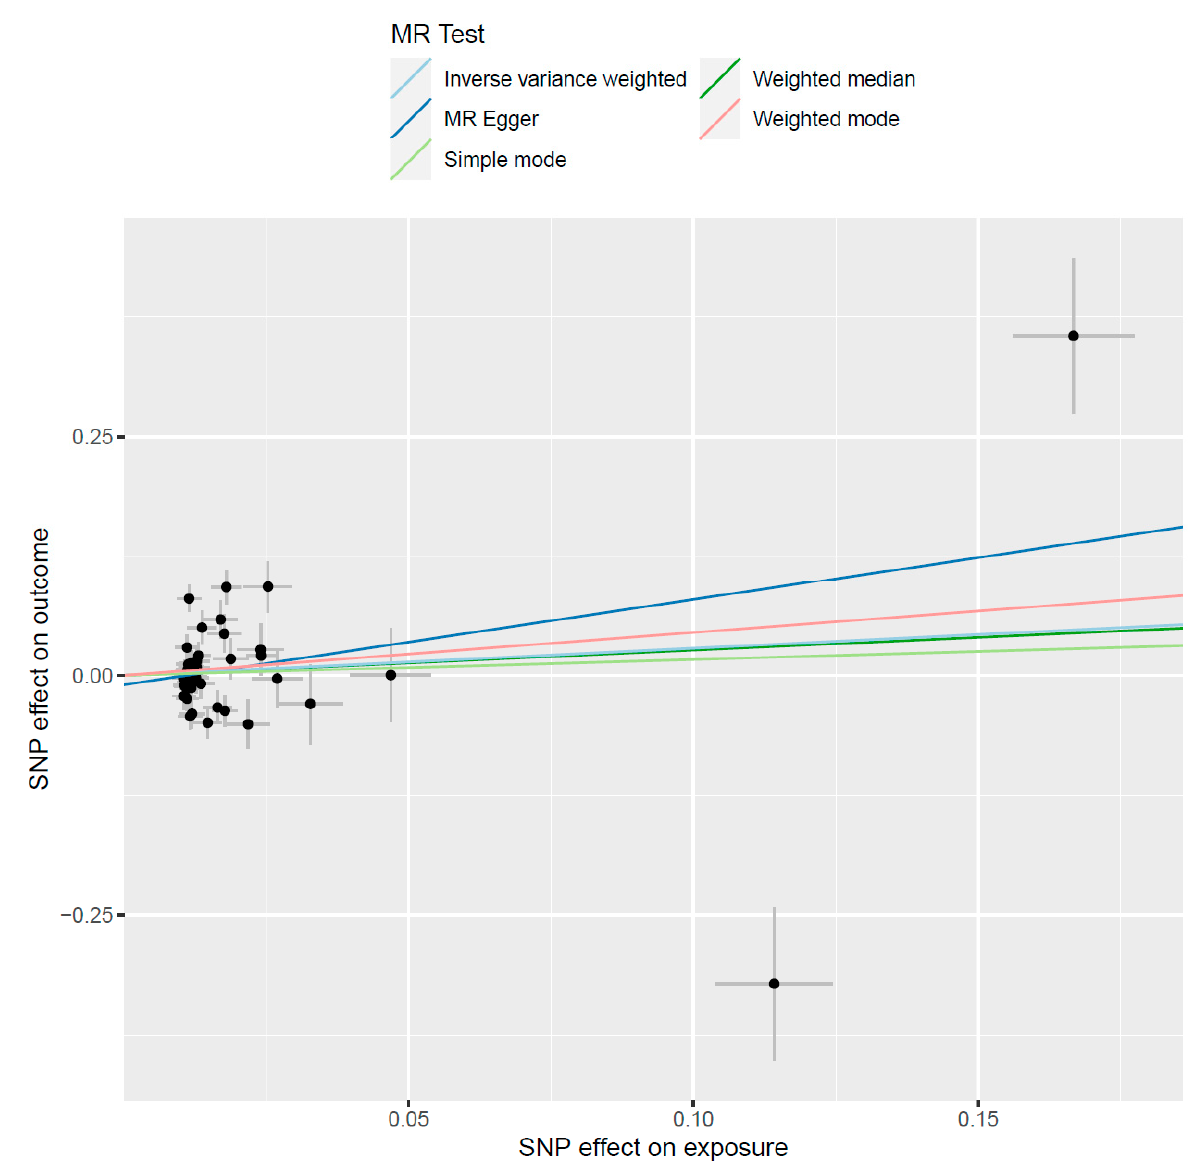
Figure 1. Causal effects of alcohol consumption on the risk of developing gout. The black circles represent the effect of individual SNPs on outcome and exposure, while the grey lines show their standard errors.